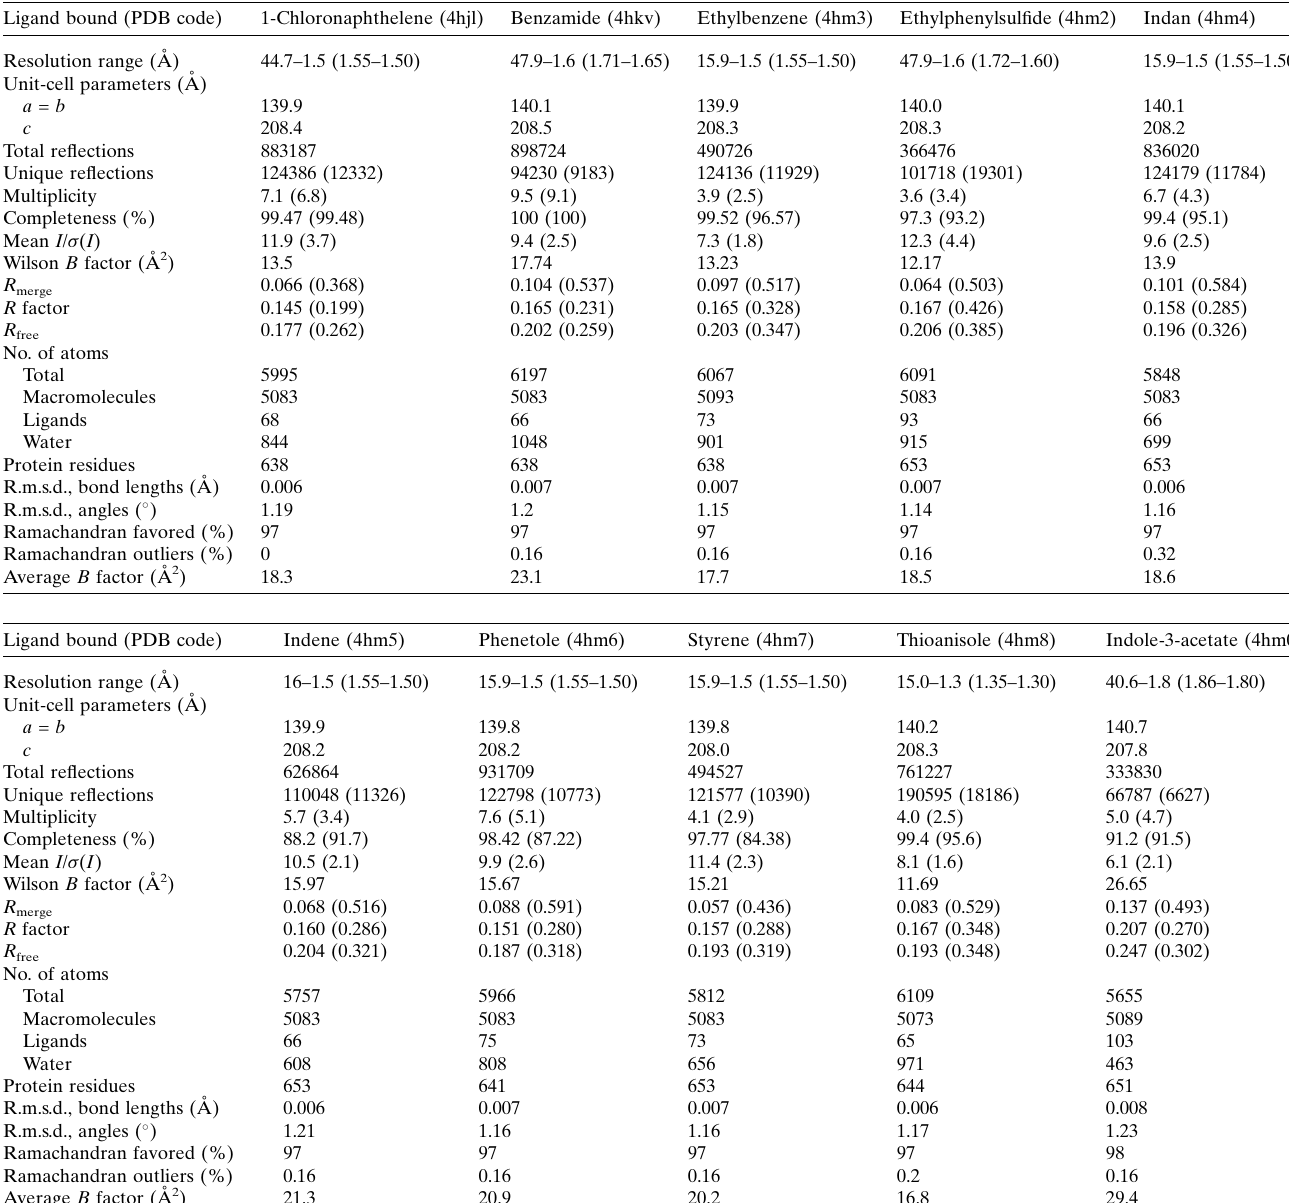
Table 1 Crystallographic data for the reported structures. Values in parentheses are for the highest resolution